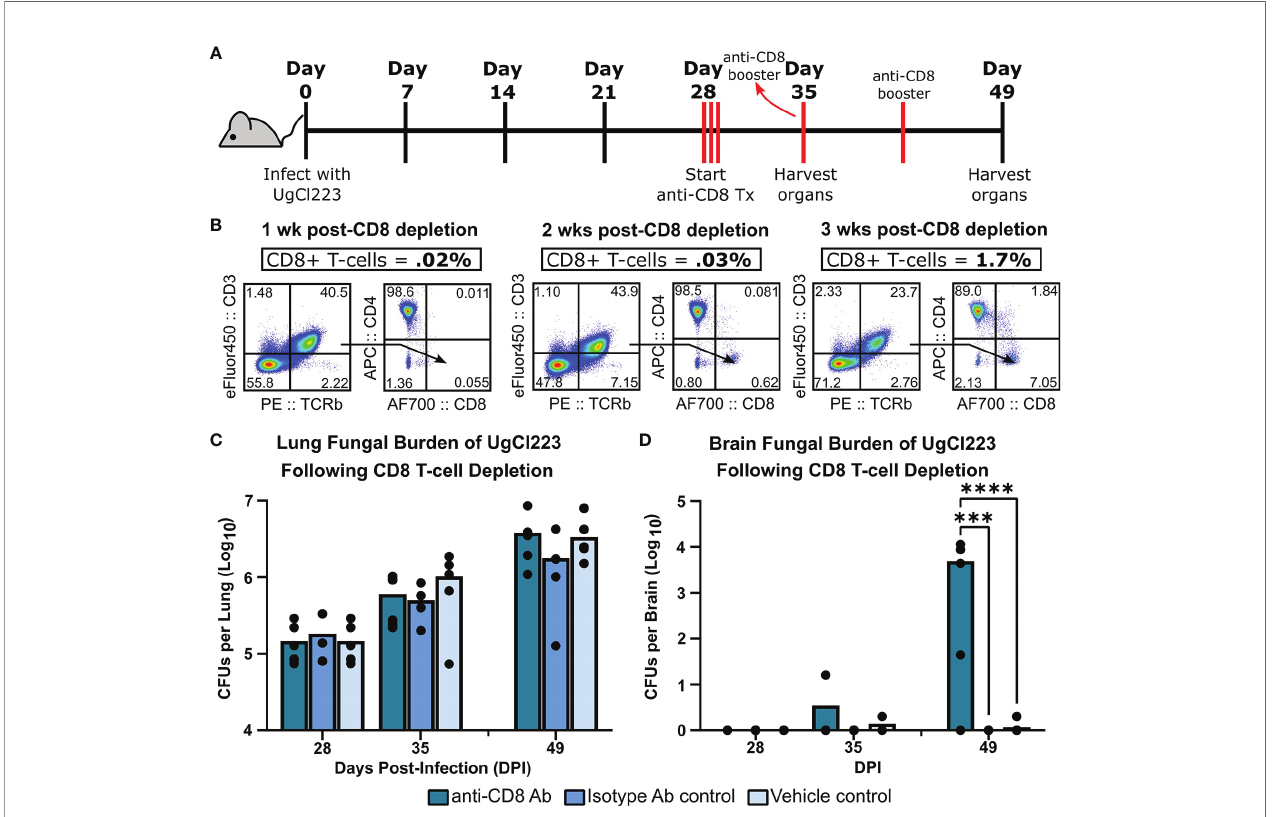
FIGURE 7 | CD8 T-cells were not required to control lung fungal burden during UgCl223 infection. (A) Experimental timeline showing C57BL/6 mice were intranasally infected with UgCl223 and treated with 15 mg/kg CD8 monoclonal antibody (2.43) starting at 28 days post-infection for 3 consecutive days and then weekly with booster injections. (B) Representative fl ow cytometric plots showing CD4+CD8- and CD4-CD8+ T-cells isolated from the lungs of infected mice at 1- week post-CD8 depletion (left), 2-weeks post-CD8 depletion (middle), and 3-weeks post-CD8 depletion (right). The gating strategy of the fl ow cytometric plots was doublet exclusion, gating on live cells, gating on CD3+/TCR b + cells, then gating on CD4+CD8- T-cells and CD4-CD8+ T-cells. Frequency of CD3+TCR b +CD4-CD8+ T-cells was determined by calculating the percentage of CD3+TCR b +CD4-CD8+ T-cells out of the grandparent gate (i.e., live singlet lymphocytes). (C) Lungs and (D) brain were analyzed for CFUs at 28-, 35-, and 49-days post-infection. n = 4-5 mice per timepoint per group. ***p < 0.0001, ****p < 0.00001 by two-way